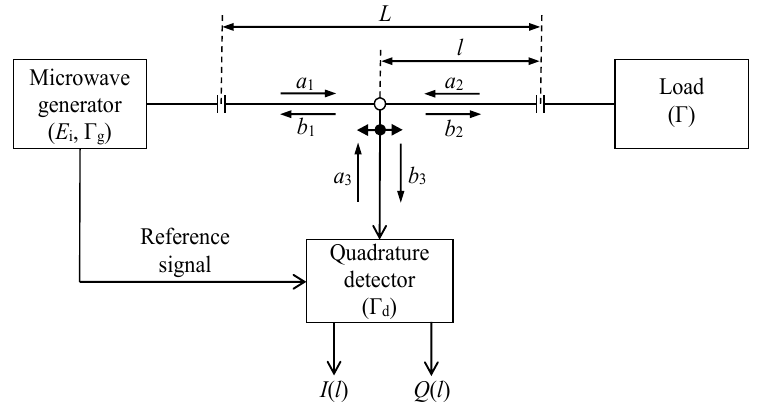
Fig. 1. Block diagram of the microwave part of the CRC meter